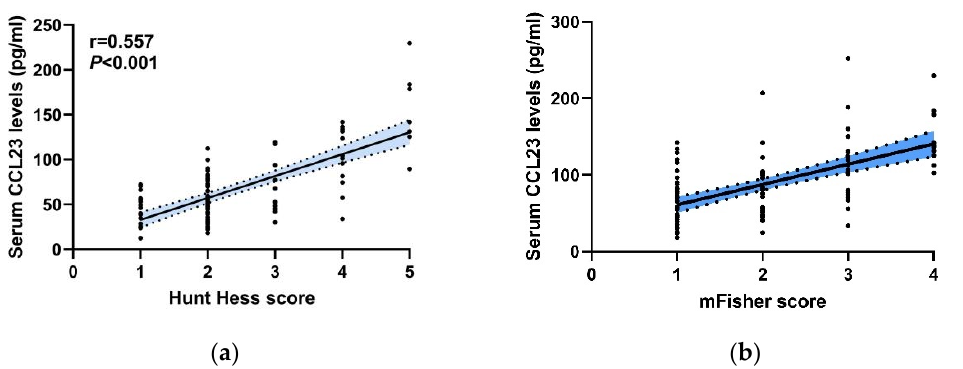
Figure 3. Correlation between serum CCL23 levels with initial clinical severity. ( a ) Scatterplot and regression line show correlation between serum CCL23 levels and Hunt–Hess score at admission. ( b ) Scatterplot and regression line show correlation between serum CCL23 levels and mFisher score at admission. The blue areas represent 95%CI of the regression line; r means Spearmen’s correlation coefficient of two factors.